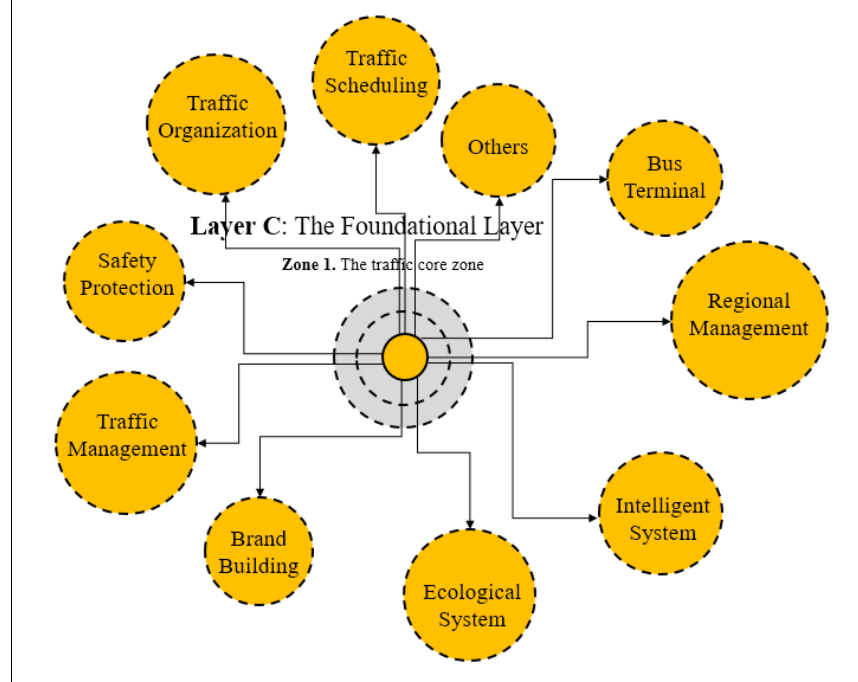
Figure 18. The main characters of Zone 1 in Layer C.